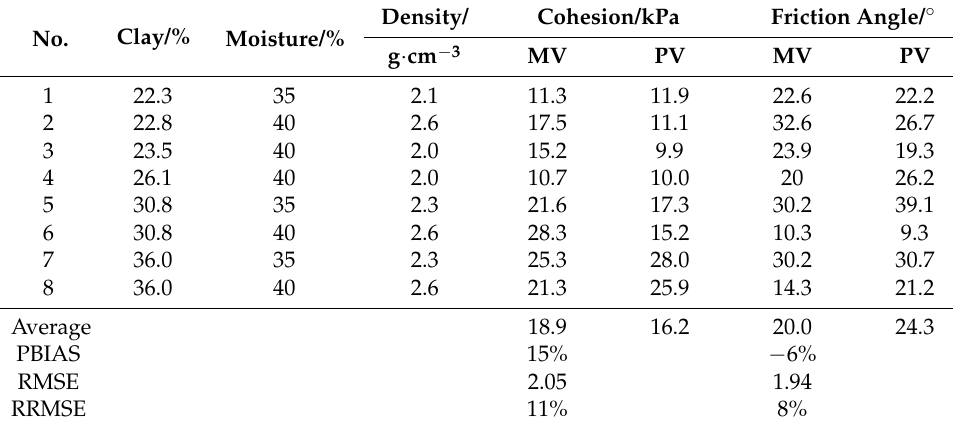
Table 5. The measured and predicted values of the shear parameters